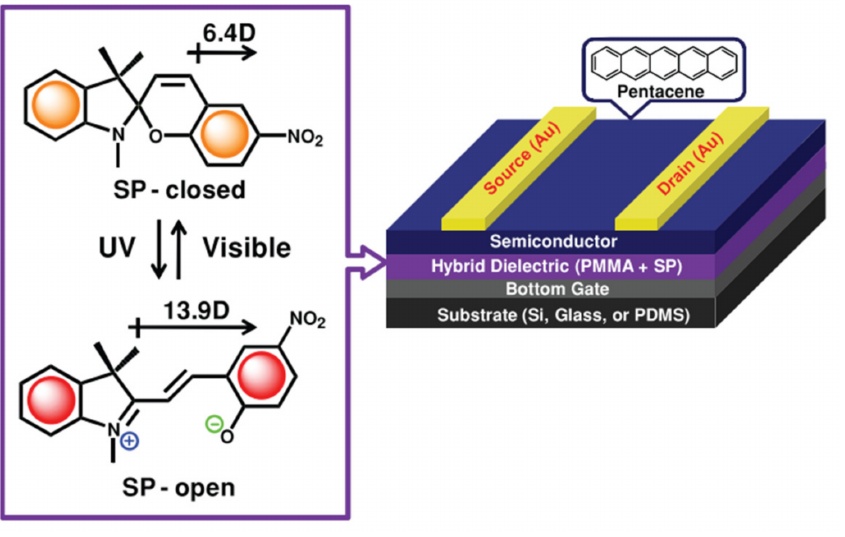
Figure 10. Reversible isomerisation reaction and device structure. Reprinted with permission from ref. [110]. Copyright 2010 John Wiley &